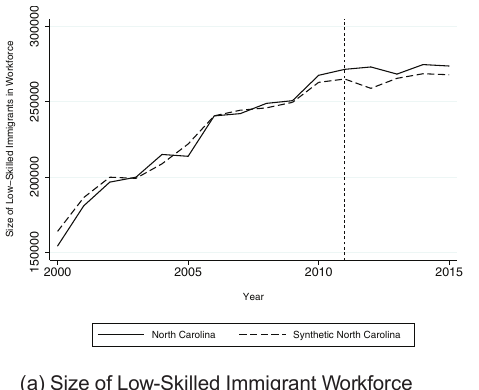
Figure A7 North carolina universal e-verify and size of low-skilled immigrant workforce